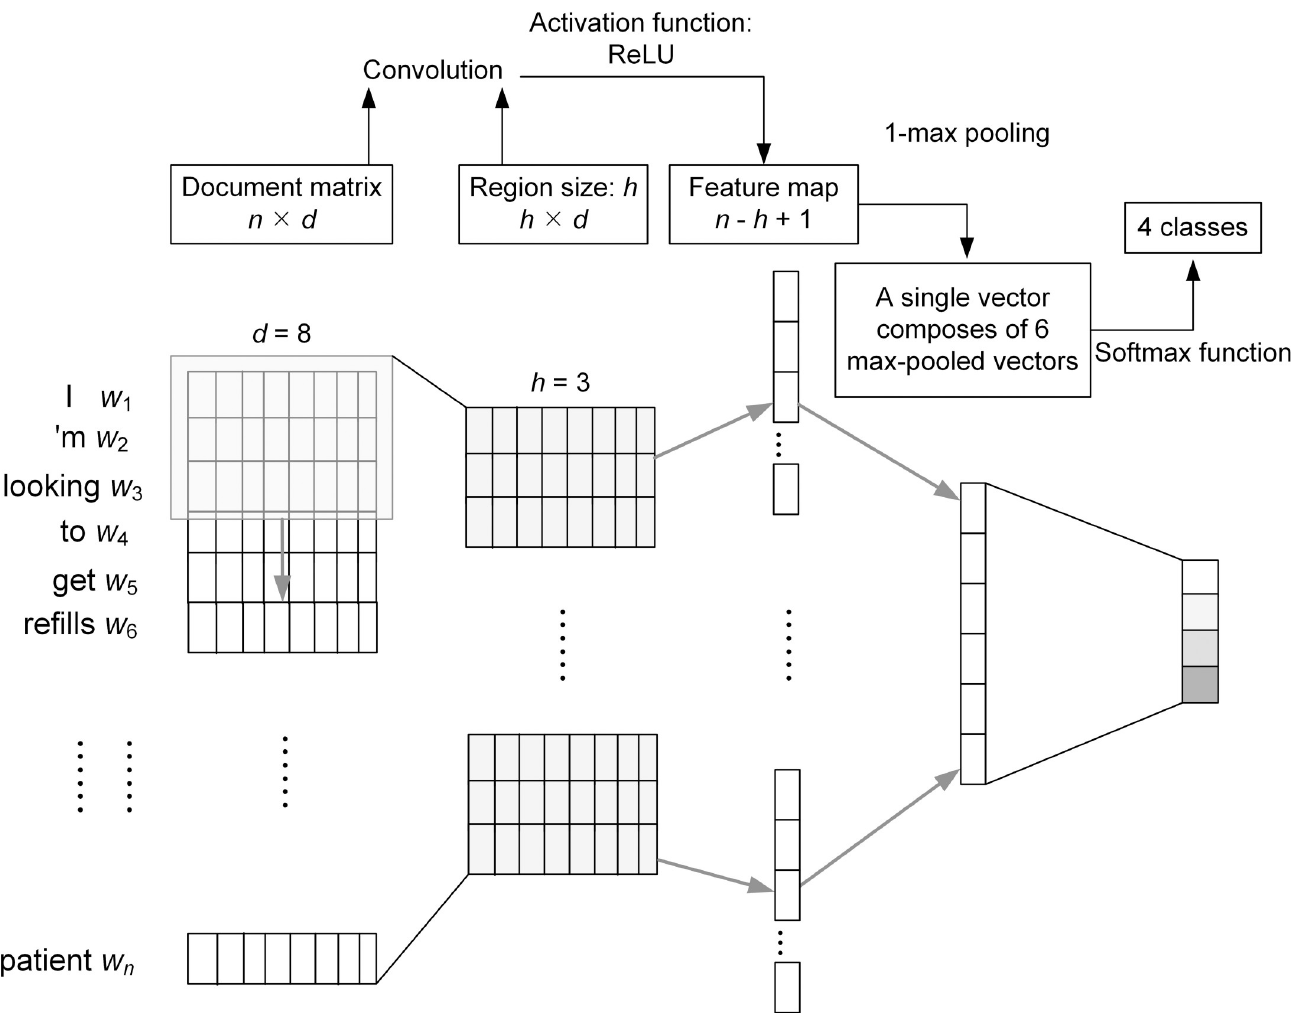
Fig 1. A basic deep convolutional neural network based severity classification